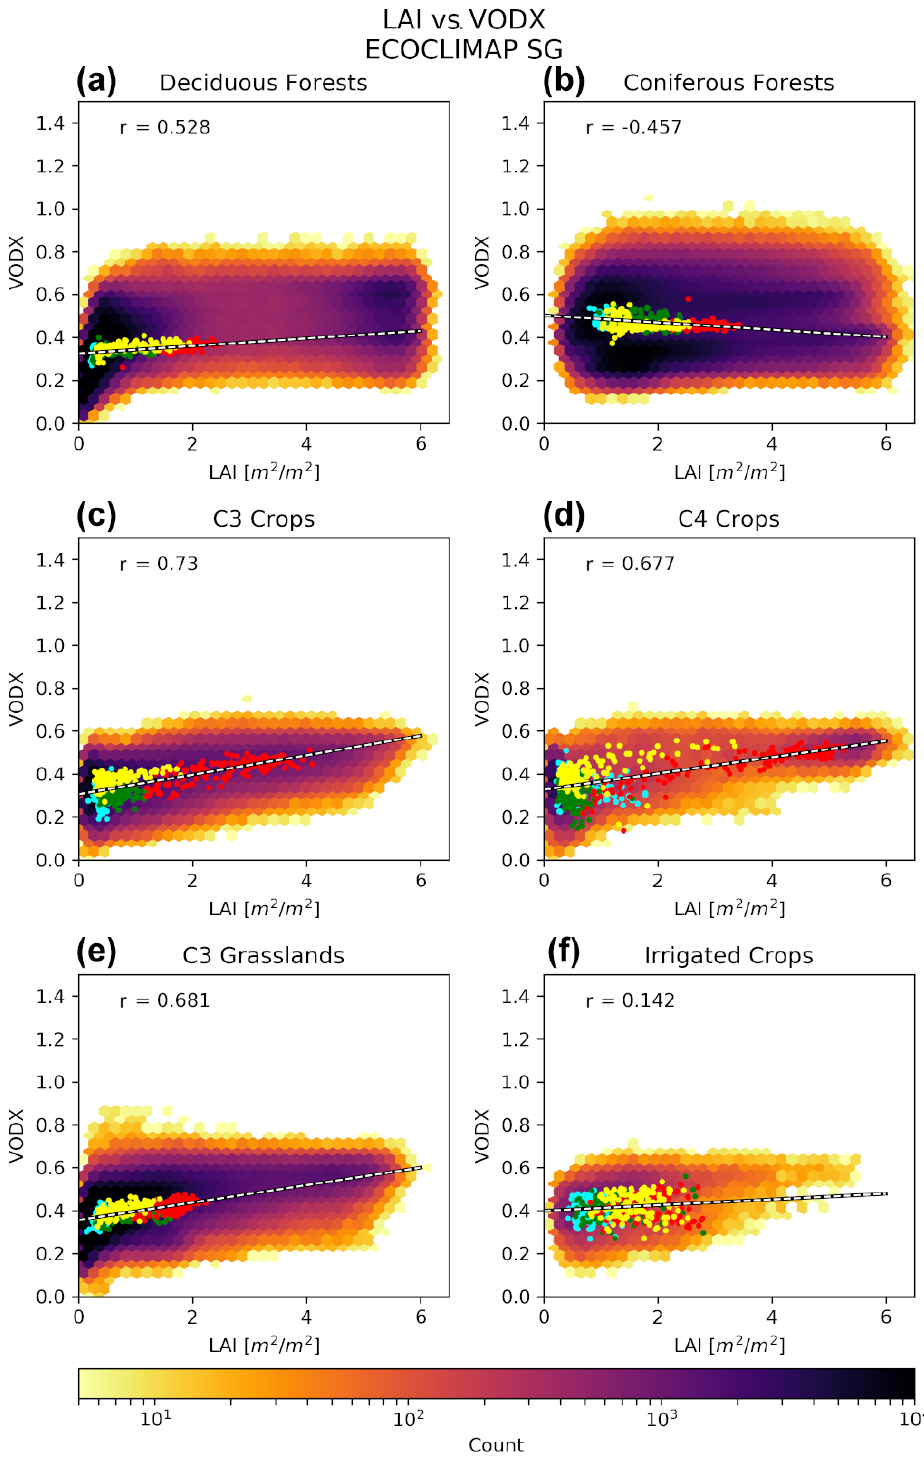
Figure 5. Density scatterplots detailing the relationship between LAI and VODX from VODCA over six dominant vegetation types: (a) de- ciduous forests, (b) coniferous forests, (c) C 3 crops, (d) C 4 crops, (e) C 3 grasslands, and (f) irrigated crops for the years 2003 to 2018. Dominant vegetation is defined as where 50% or more of a patch contains a single vegetation type. Higher concentrations of points trend towards black. Colored dots represent the spatial average over the four seasons, where cyan is winter, green is spring, red is summer, and yellow is autumn. Dashed black-and-white lines represent the linear regression of the seasonal